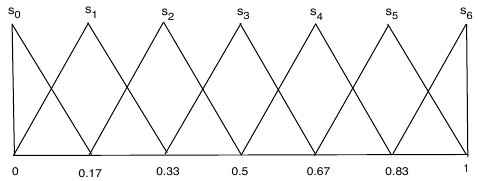
Figure 2. A linguistic term set S = { s 0 , s 1 , s 2 , . . . , s 6 }